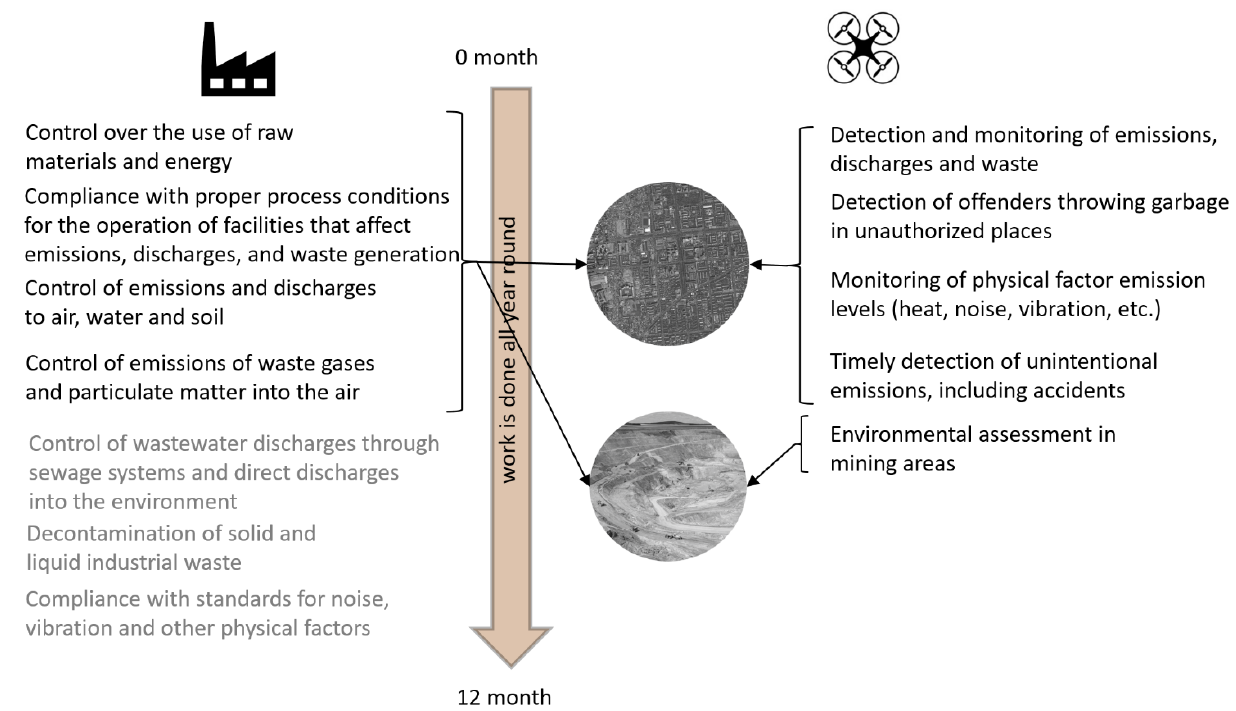
Figure 4. Environmental monitoring tasks and UAVs capabilities. Source: Generated by the authors.